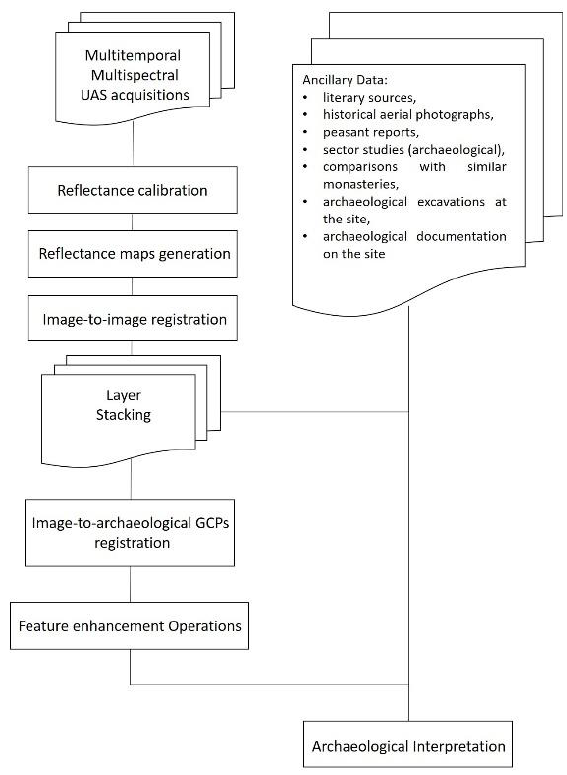
Figure 5. Figure 5. Flowchart.